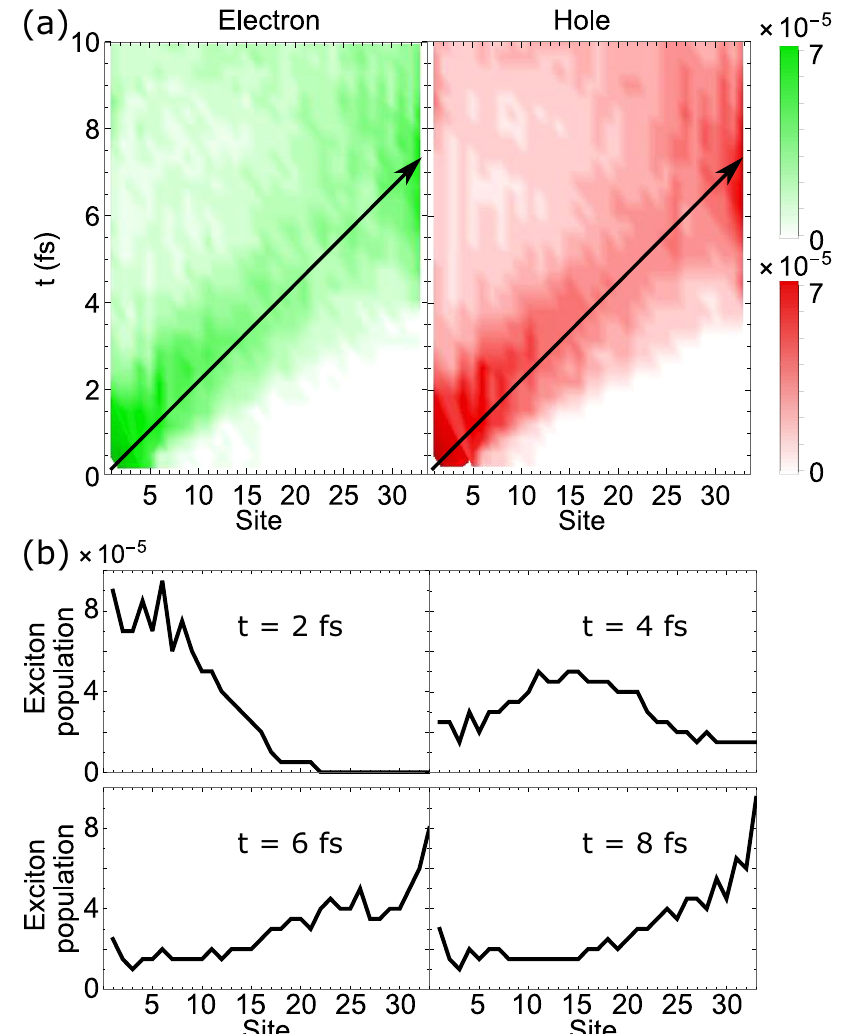
Fig. 7 Exciton wave packet. a Electron and hole populations at different sites as functions of time. b Exciton population at different sites at speci fi c times. The results refer to the short laser pulse of Fig.